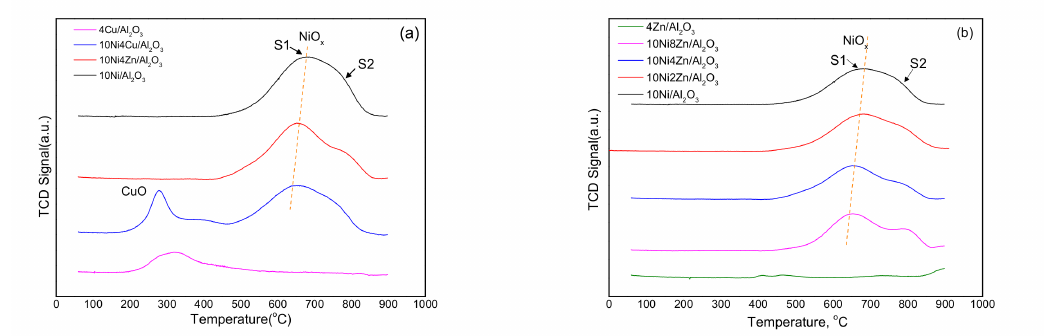
Figure 4. The H 2 -TPR profiles of ( a ) 10Ni / Al 2 O 3 , 10Ni4Zn / Al 2 O 3 , 10Ni4Cu / Al 2 O 3 , Cu / Al 2 O 3 and ( b ) 10Ni / Al 2 O 3 , 10Ni2Zn / Al 2 O 3 , 10Ni4Zn / Al 2 O 3 , 10Ni8Zn / Al 2 O 3 , 4Zn / Al 2 O 3